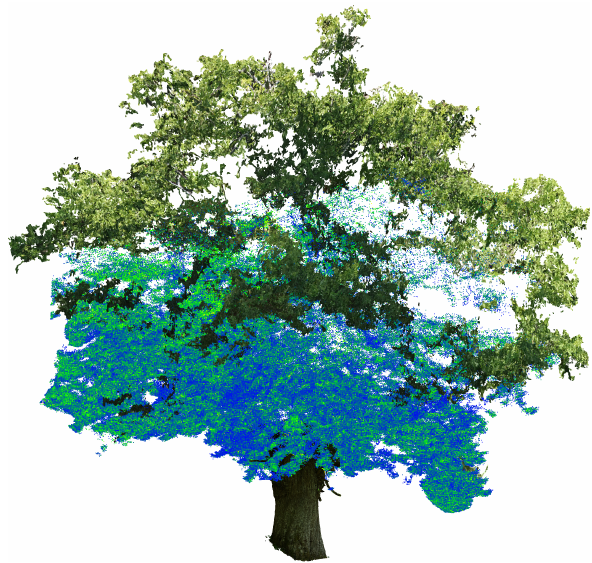
Figure 6. 3D tree model: upper crown by UAV, lower crown by MLS and trunk by